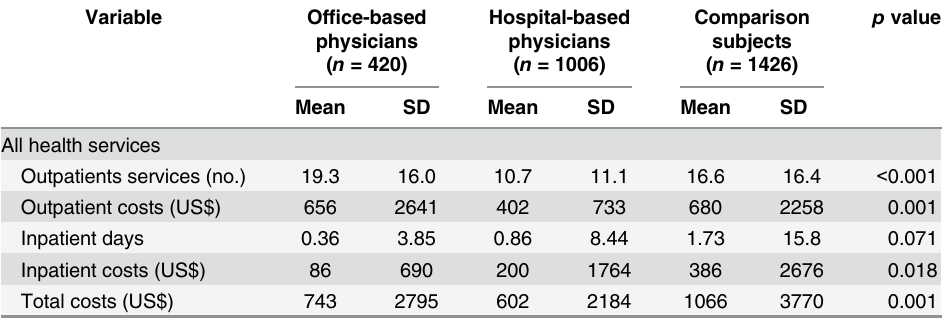
Table 3. Use and costs (US$) of healthcare services in the year 2010 by office-based physicians, hos- pital-based physicians, and comparison